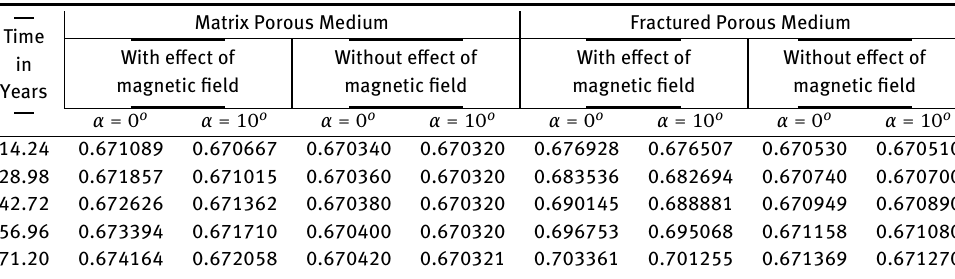
Table 6: Numerical values of saturation rate in glass beads and in an inclined fractured and matrix porous medium with the effect of mag- netic field